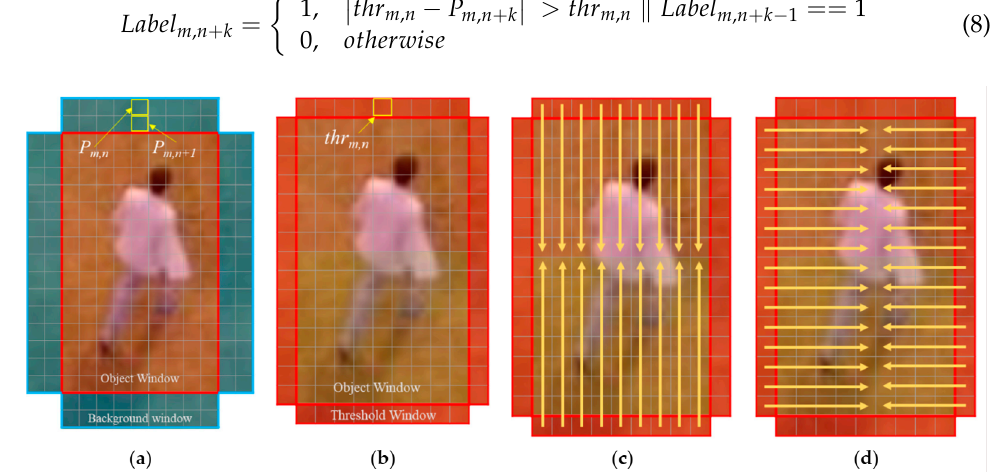
Figure 6. The demonstration of dynamic threshold-value scanning. ( a , b ) The threshold value ( thr ) is finding the difference of the characteristics value ( P m,n and P m,n+1 ) in the background window; ( c ) vertically scanning process; ( d ) horizontally scanning process.